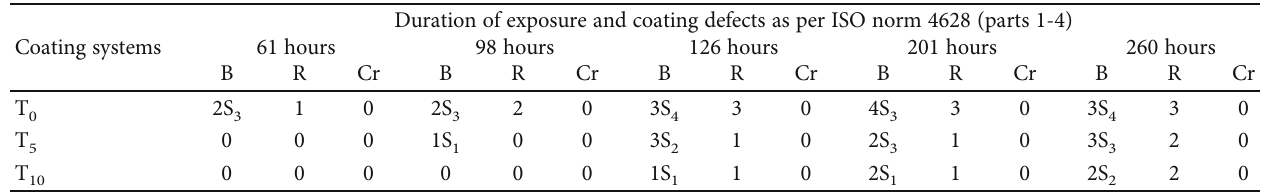
Table 6: Defect rating as per ISO norm 4628 (parts 1-4) in the virgin epoxy coating and titanium-embedded epoxy coatings after salt spray testing. Coating systems